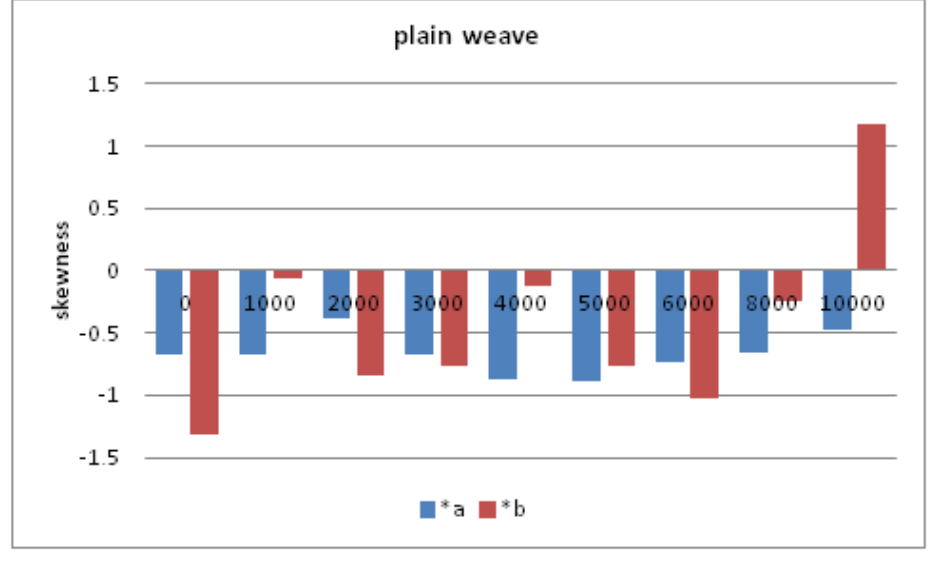
Figure 7. Skewness graph—Fabric 4.